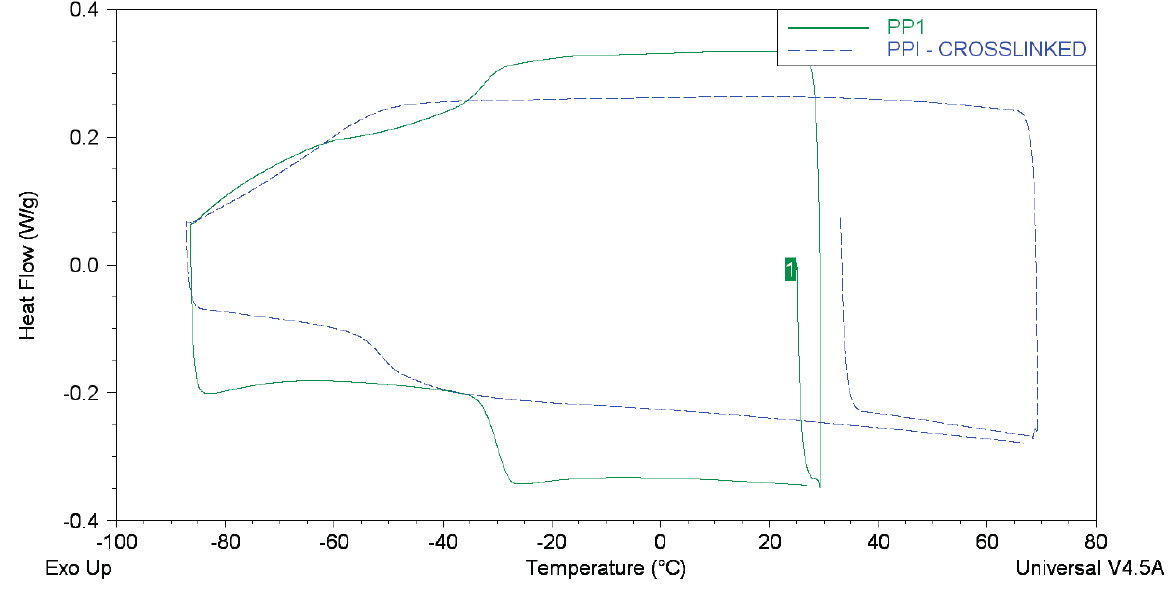
Figure 6. DSC Traces for PPI (solid line) and crosslinked PPI (dashed line).